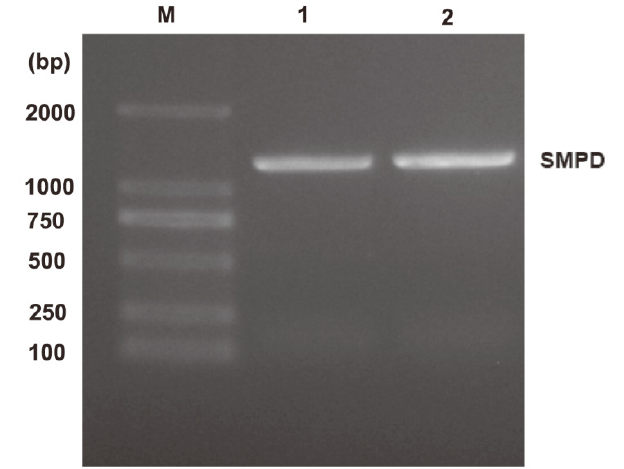
Fig 1 . PCR amplification of SMPD gene sequence from B. lantschouensis . M, molecular mass marker D2000; lane 1 and 2, amplified product (about